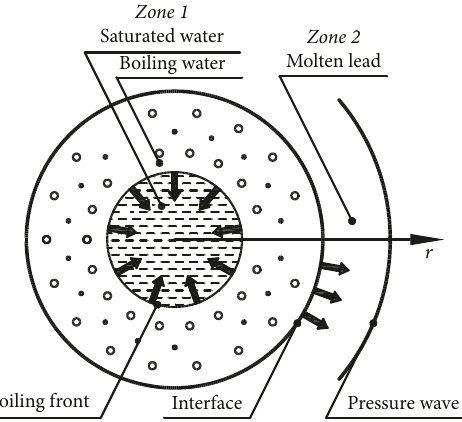
Figure 1: Sketch of the main zones for expansion of superheated water into liquid